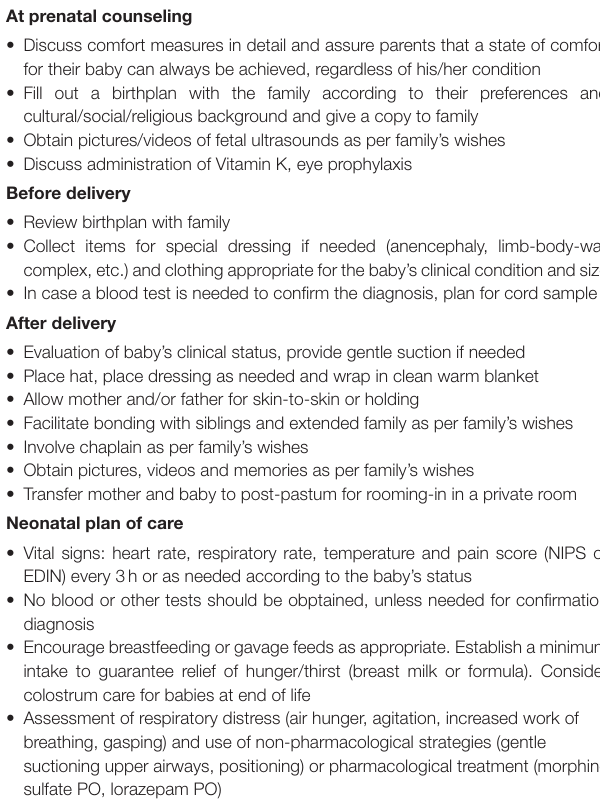
TABLE 2 | Guidelines to provide comfort to neonates with life-threatening or terminal conditions in the